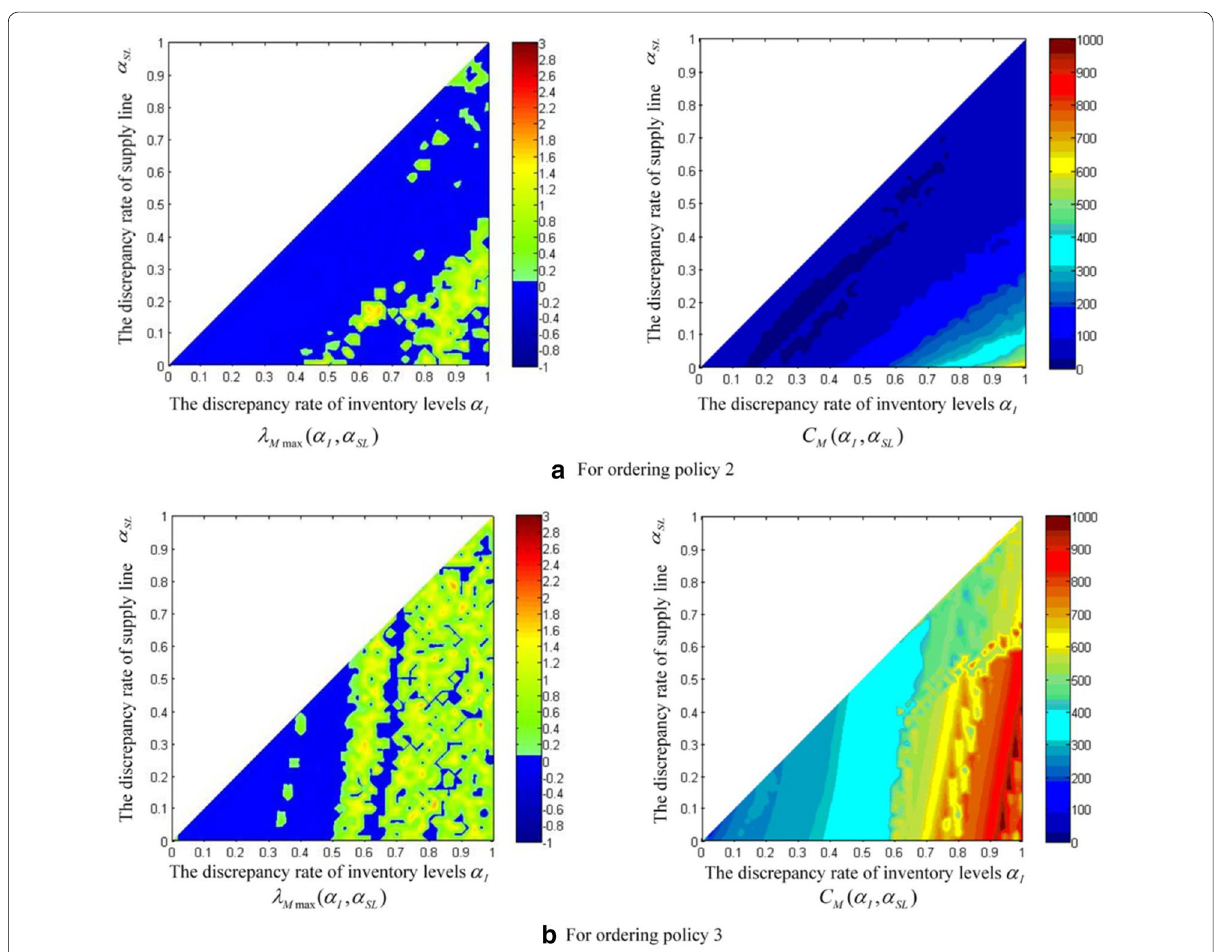
Figure 6 Distribution of (cid:31) M max and C M for the manufacturer in the case of different ordering